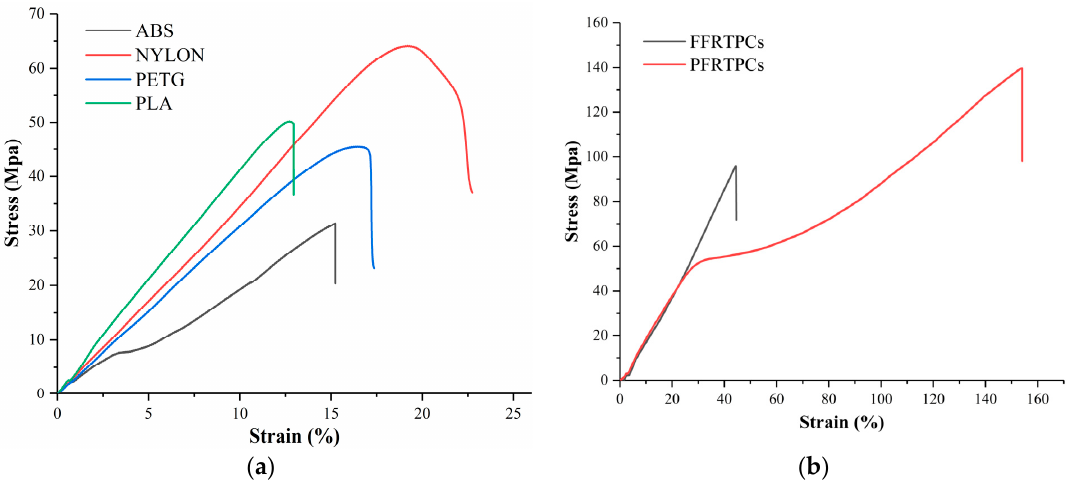
Figure 8. Stress-strain diagram of tensile test. ( a ) Stress-strain diagram of referenced pure polymers. ( b ) Stress-strain diagram of fiber-reinforced polymers.